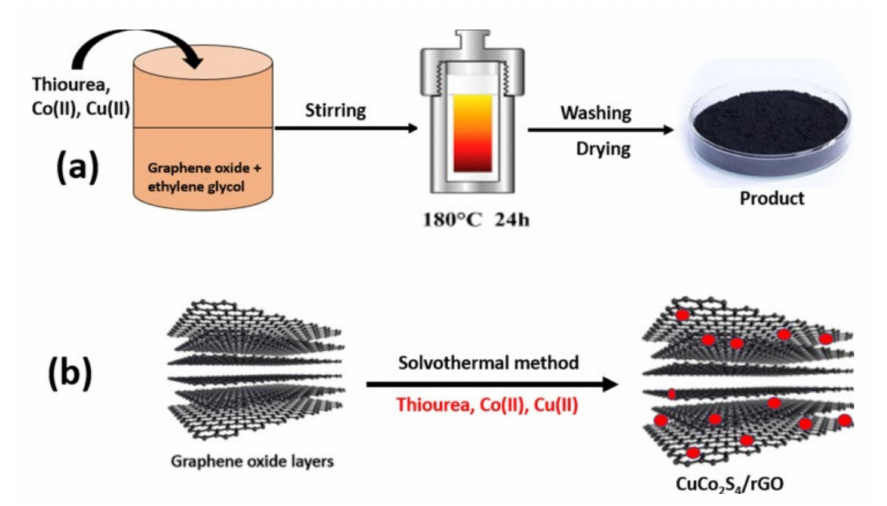
Figure 5. Schematic diagram of ( a ) synthesis and ( b ) formation of CuCO2S4/rGO